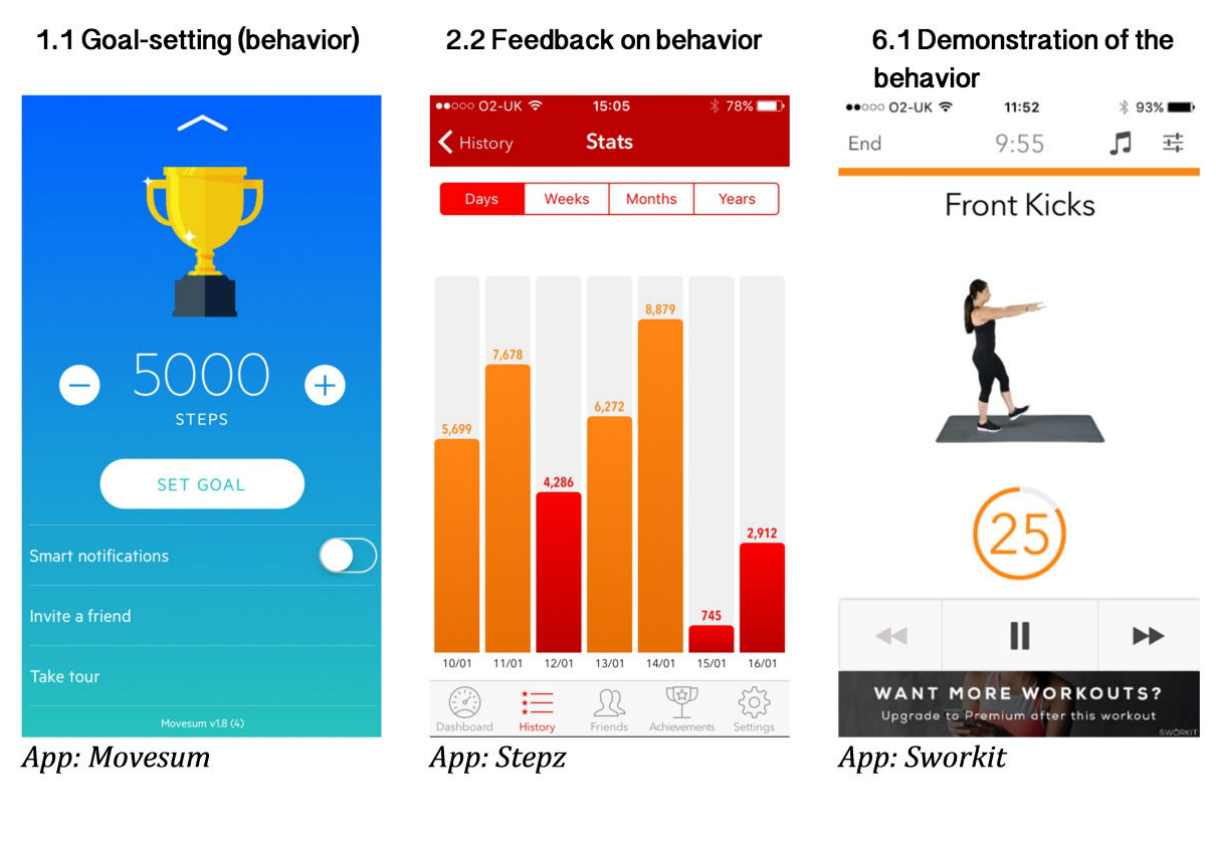
Figure 3. Examples of the most common behavior change techniques (BCTs) from the most frequent BCT groups: (1) goals and planning: 1.1 Goal setting (behavior), (2) feedback and monitoring: 2.2 Feedback on behavior, and (3) comparison of behavior: 6.1 Demonstration of the behavior.